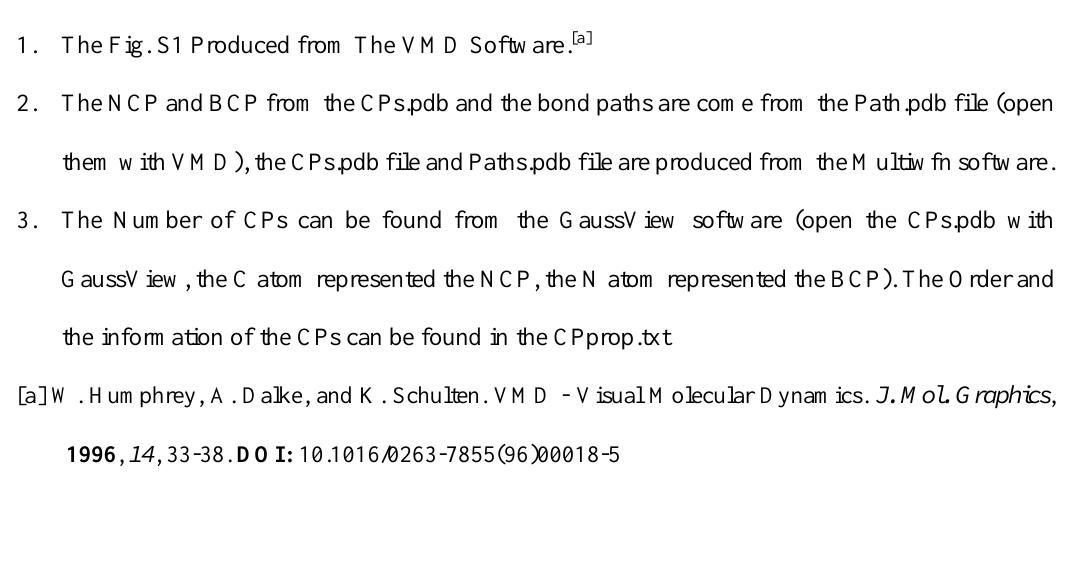
Fig. S1 The hydrogen bonds with full BCPs (yellow dots) and Nuclear Critical Points (NCPs, pink ball) and the bond paths of the three coordination units model of the compound.